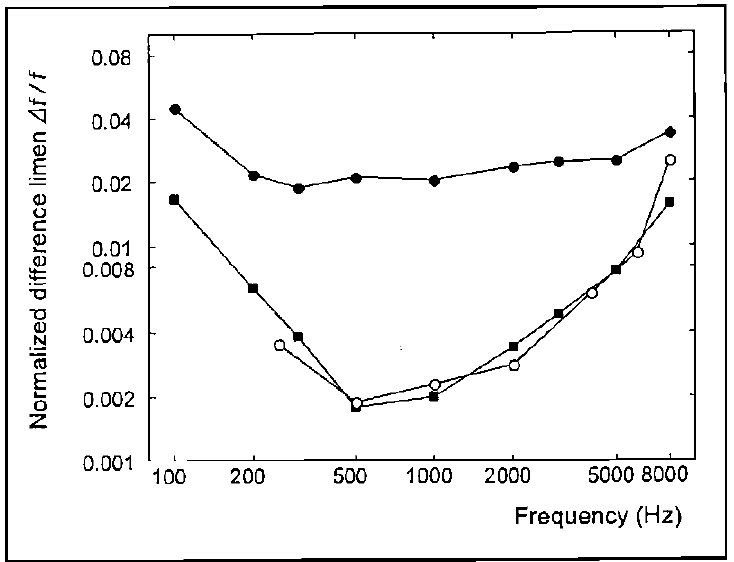
FIGURE 2. Values of the frequency difference limen Af expressed as a proportion of frequency ( Aflf ) are plotted as a function of the frequency of a pure tone stimulus on logarithmic axes. Filled squares are model predictions for acoustic stimulation, while open circles are the perceptual frequency discrimination data of Sek and Moore (1995). Filled circles are model predictions for electrical